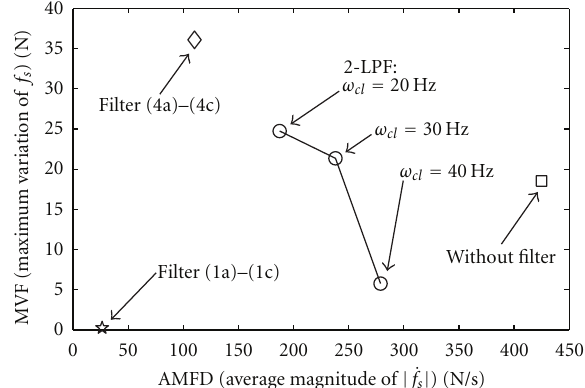
Table 1: Parameter values.